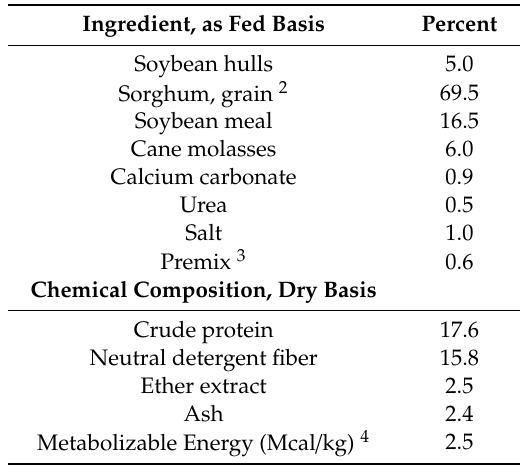
Table 1. Base feed composition used to prepare the experimental diets.